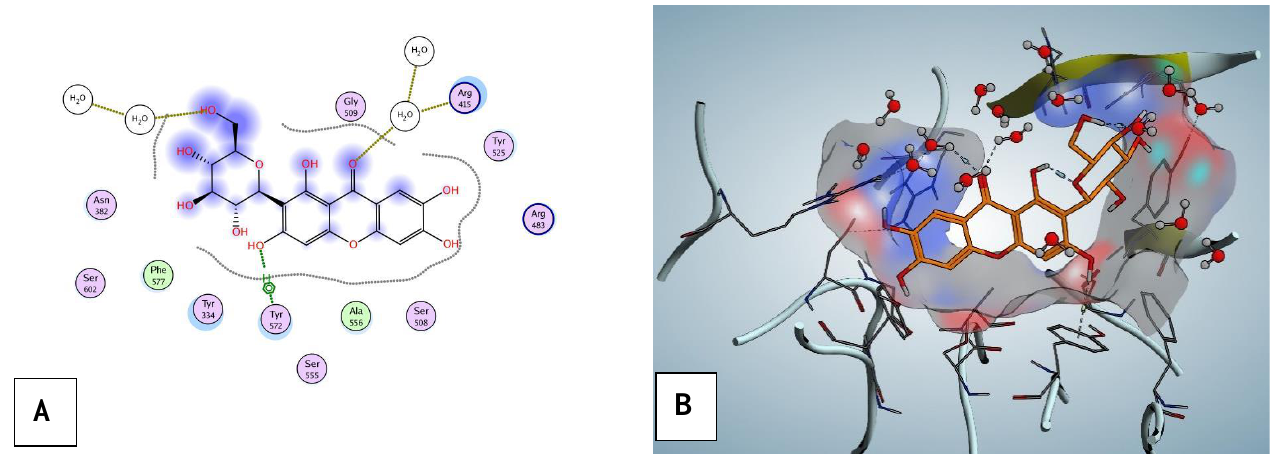
Figure 10. Nrf2 protien structure (PDB: 1X2R) ( A ) 2D and ( B ) 3D diagrams show the interaction of mangiferin (orange) in the binding pocket.